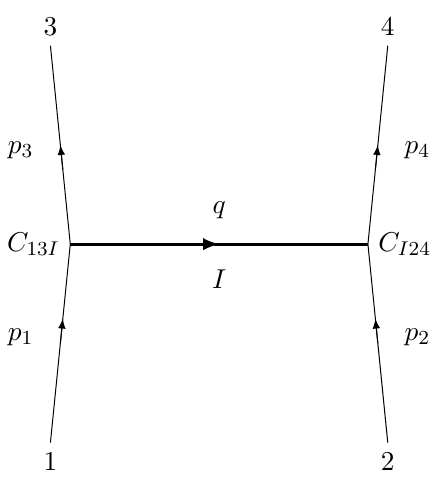
Figure 3 . Eikonal scattering of particles. In this highly boosted kinematics, particles are moving almost in the null directions such that the center of mass energy is